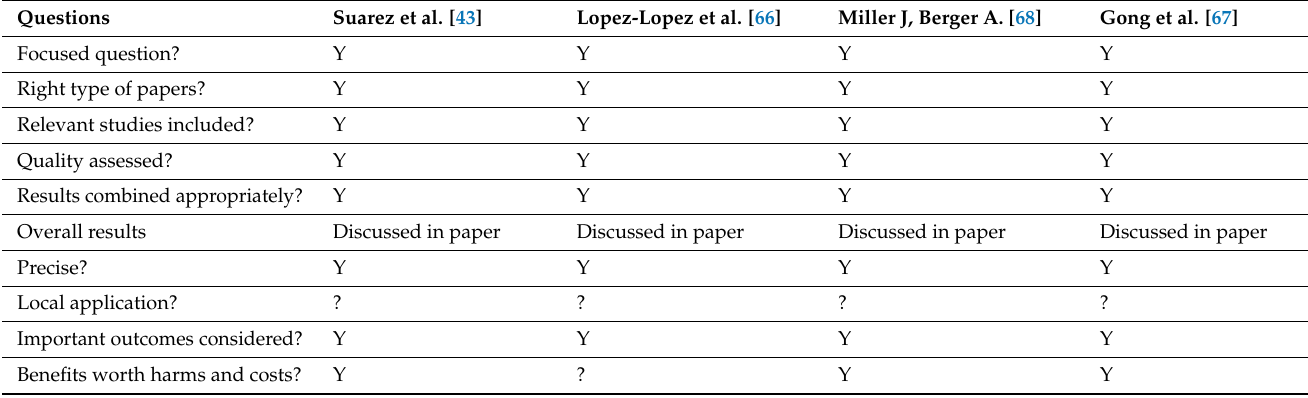
Table A1. Systematic review/meta-analysis checklist.